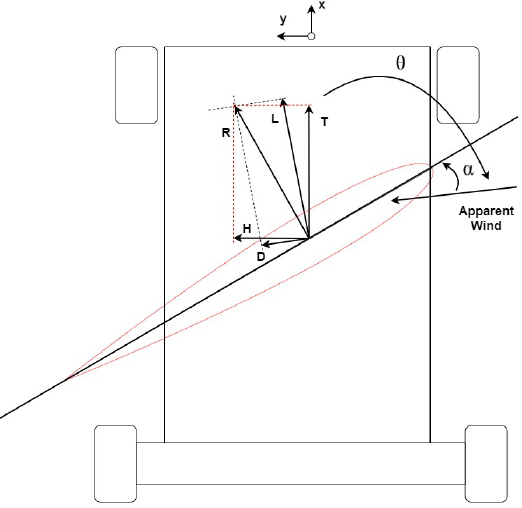
Figure 2. Land yacht